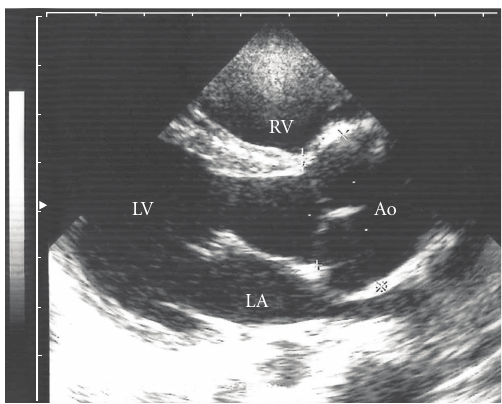
Figure 2: Parasternal long-axis view of left ventricle (LV) shows severe dilatation of the aortic root at the age of almost 4 years. Diameter of the aortic root is 32.2 mm. LA: left atrium; LV: left ventricle; RV: right ventricle; Ao: aorta. FBN1 gene c.3396delA (p.Glu1133ArgfsX29) confirming